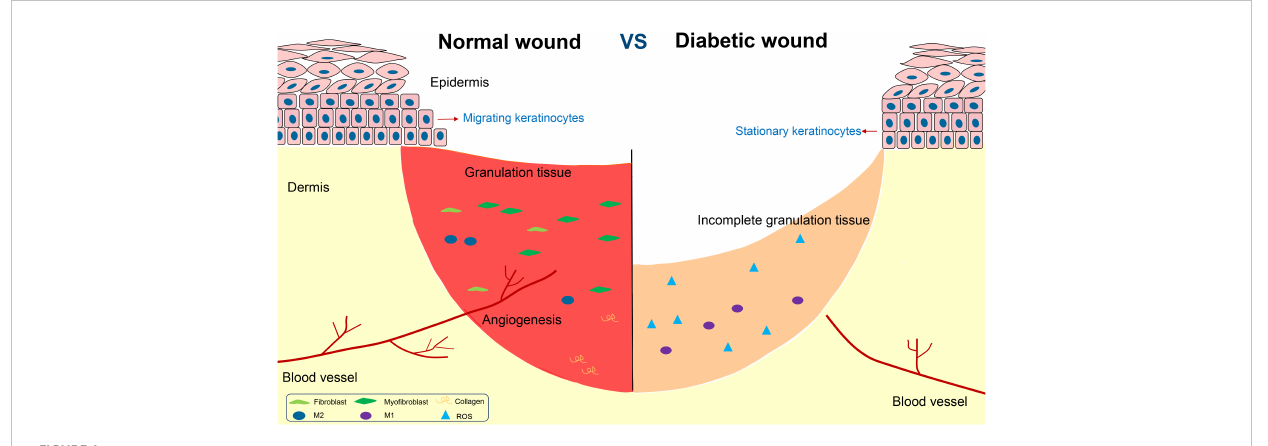
FIGURE 1 The disorders in the repair of chronic diabetic